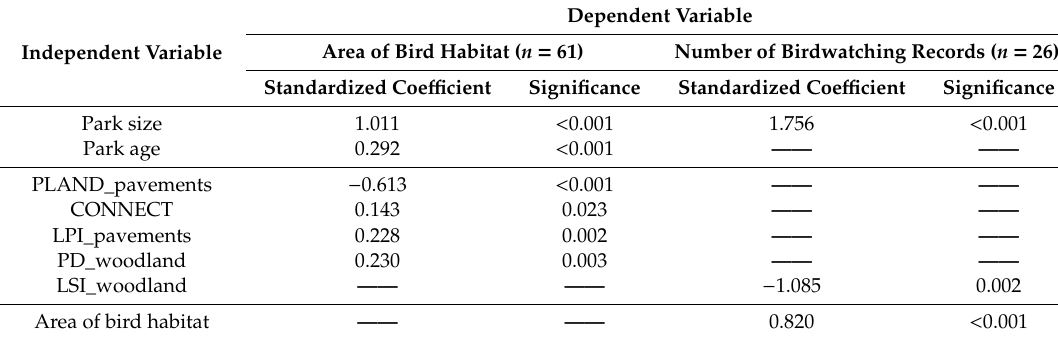
Table 2. Results of stepwise regression models of factors that may impact bird habitat area and number of birdwatching records in parks.